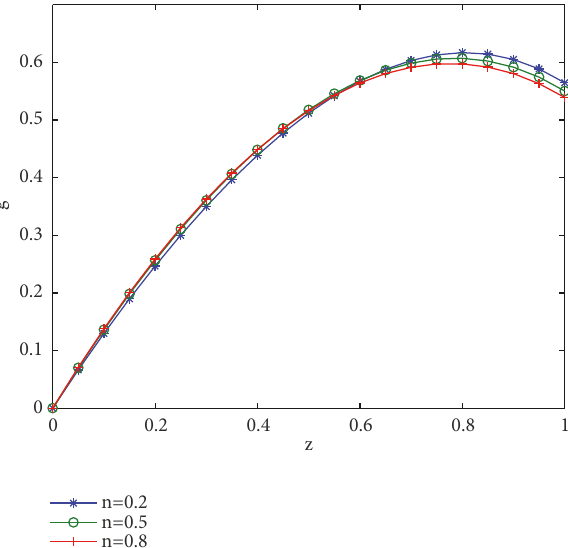
Figure 2: Flux distribution for 𝑘(𝑧) = 𝑧,ℎ(𝑧) = 1 − 𝑧, 𝛼 = 1.0, 𝑛 = 0.2, 0.5, 0.8.